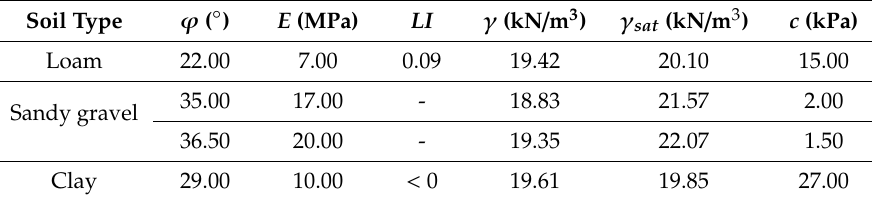
Figure 4. Zoning of the territory of Nur-Sultan city in accordance with the types of soil profiles. Table 3. Soil engineering properties in Nur-Sultan city. Soil type